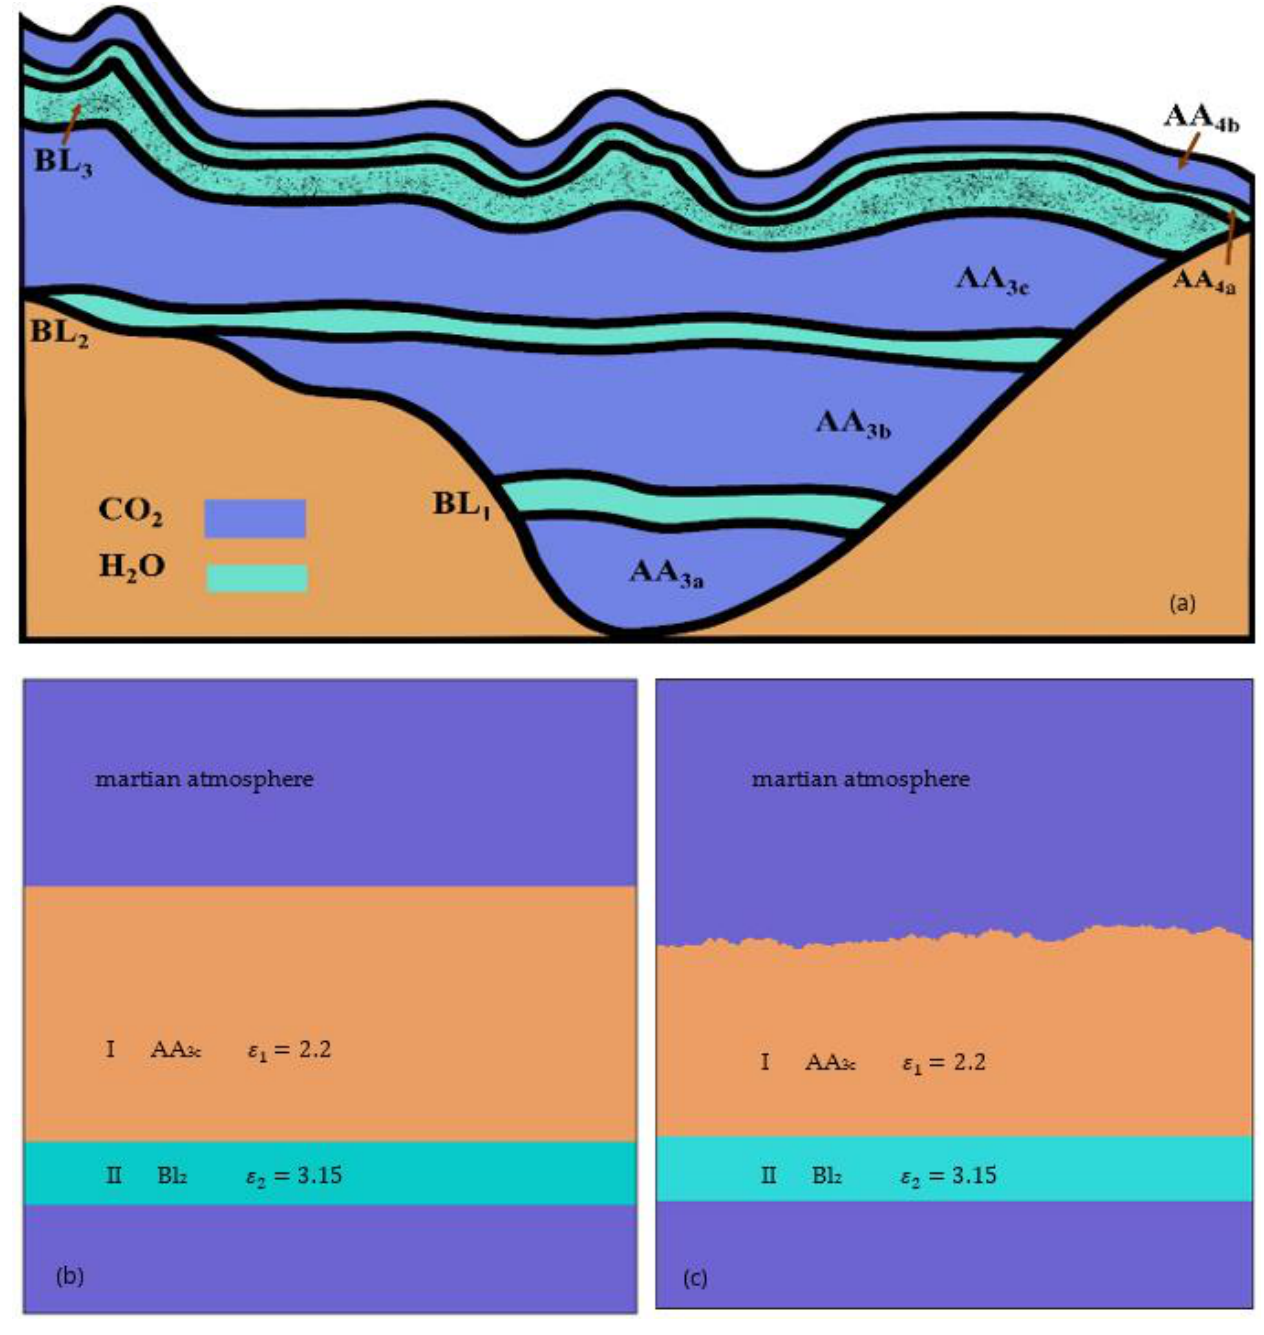
Figure 1. The shallow stratigraphy of the south polar ice cap. ( a ) The schematic diagram of the subsurface strata in the study area, adapted from the radar profile given in Bierson et al., in 2016 [8,9]. Black dots in AA 4a and BL 3 represent dust in the ice. ( b , c ): Diagram of radar simulation models (horizontal 5000× vertical 1500 m) developed based on ( a ), to evaluate the influences of surface roughness; ( b ) Smooth surface; ( c ) Rough surface to model the surface after dry ice sublimates in summer.